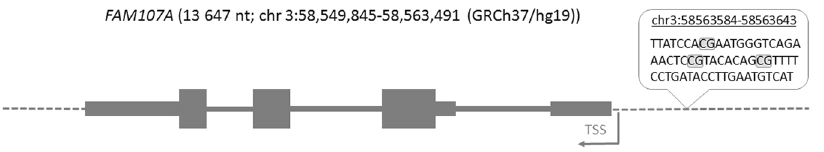
Figure 6. The structure of FAM107A gene. Three marked CG dinucleotides within the promoter region of the gene were amplified for DNA methylation (intron - exon not to scale). TSS –Transcription Start